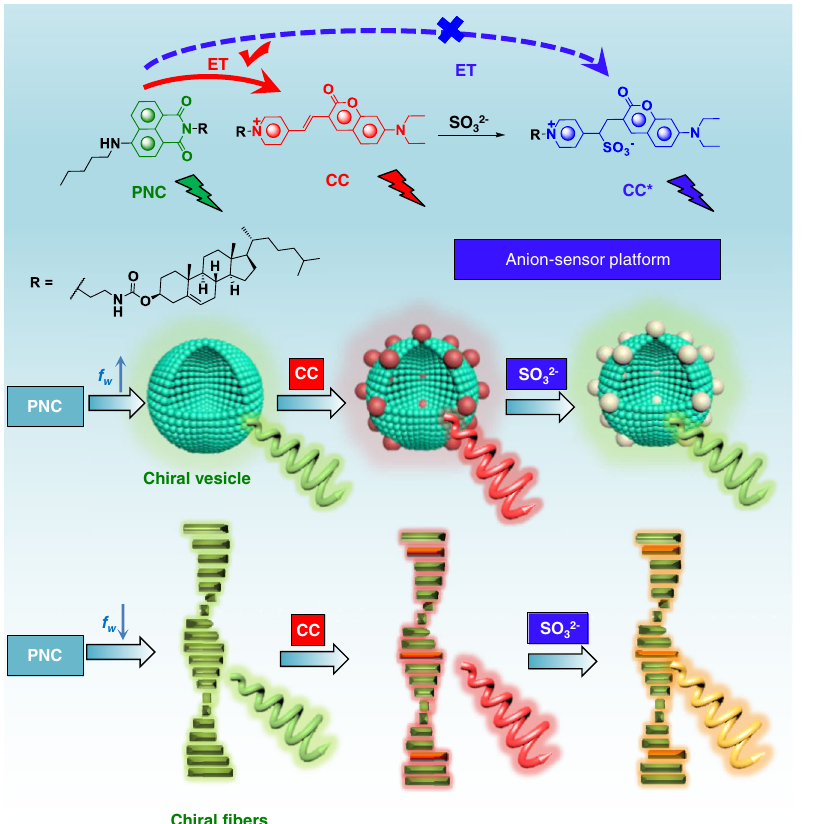
Fig. 1 Molecular structure of PNC and CC as well as the anion-responsive energy transfer effect in vesicle and helical fi ber structures mediated by water fraction (fw) (energy transfer (ET), pentylamine-substituted cholesteryl naphthalimide (PNC), cholesteryl coumarin (CC)). Blue, red, and gray particles represent PNC, CC and CC* respectively in vesicle phase. Green, red, and orange rods stand for PNC, CC and CC* respectively in chiral fi ber self- assembly. Spiral arrows represent CPL with corresponding